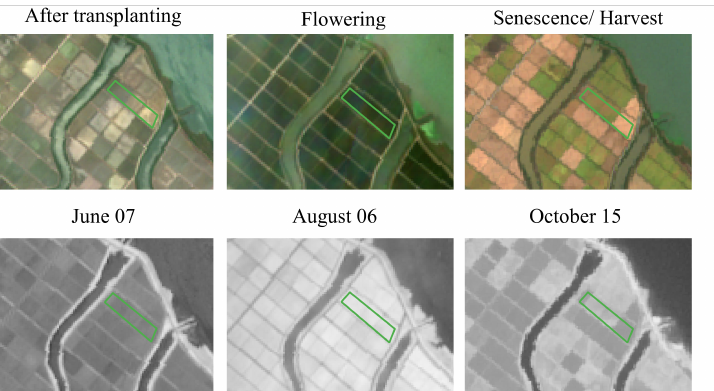
Figure 6. Examples of photo-interpretation keys based on the time-series of Sentinel-2 RGB ( top ) and NDVI images ( bottom